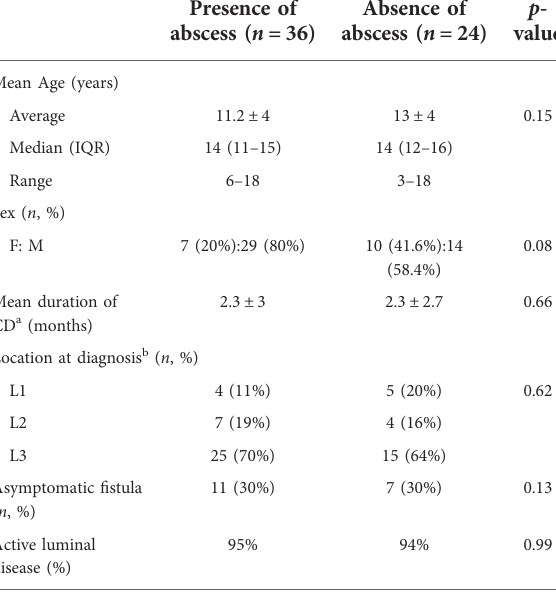
TABLE 1 Demographics and clinical characteristics of the study population.